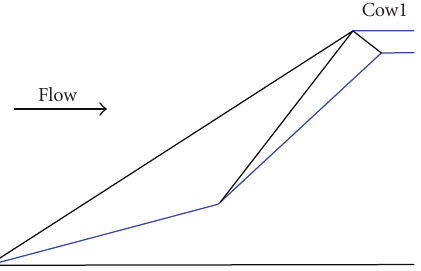
Figure 2: Optimal cowl configuration with shocks converging on the cowl